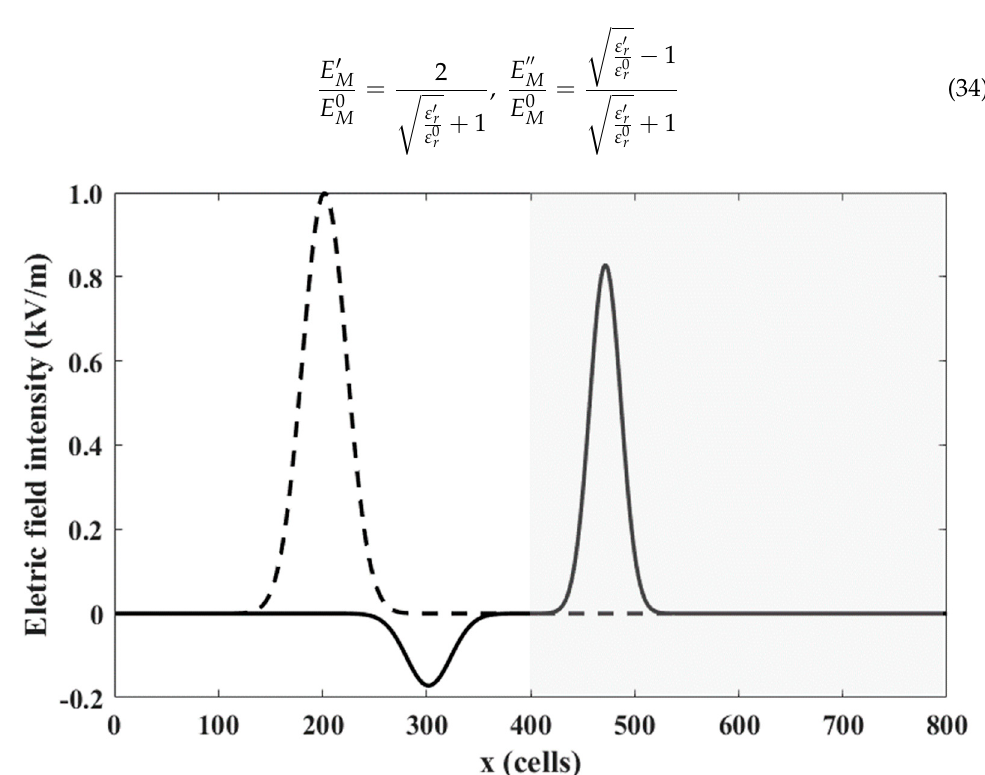
Figure 1. Distribution of electric pulse crossing a dielectric interface. The shadow zone is the dielectric media, with dielectric constant ε r = 2.0 and the other one corresponds to the media with ε r = 1.0. The curves are the intensity of the electric field at t = 0 (dashed line), and t = 300 (solid line). Based on Equation (32), the amplitude ratio of the transmitted pulse to the incident pulse is theoretically = 0.82843, whereas that for the reflected pulse to the incident pulse is theoretically = 0.17157 . Based on the proposed model, the computed values for these two ratios were 0.82761 and 0.17153, respectively. Thus, the computed values agreed well with the theoretical values, and the relative errors were less than 1%.